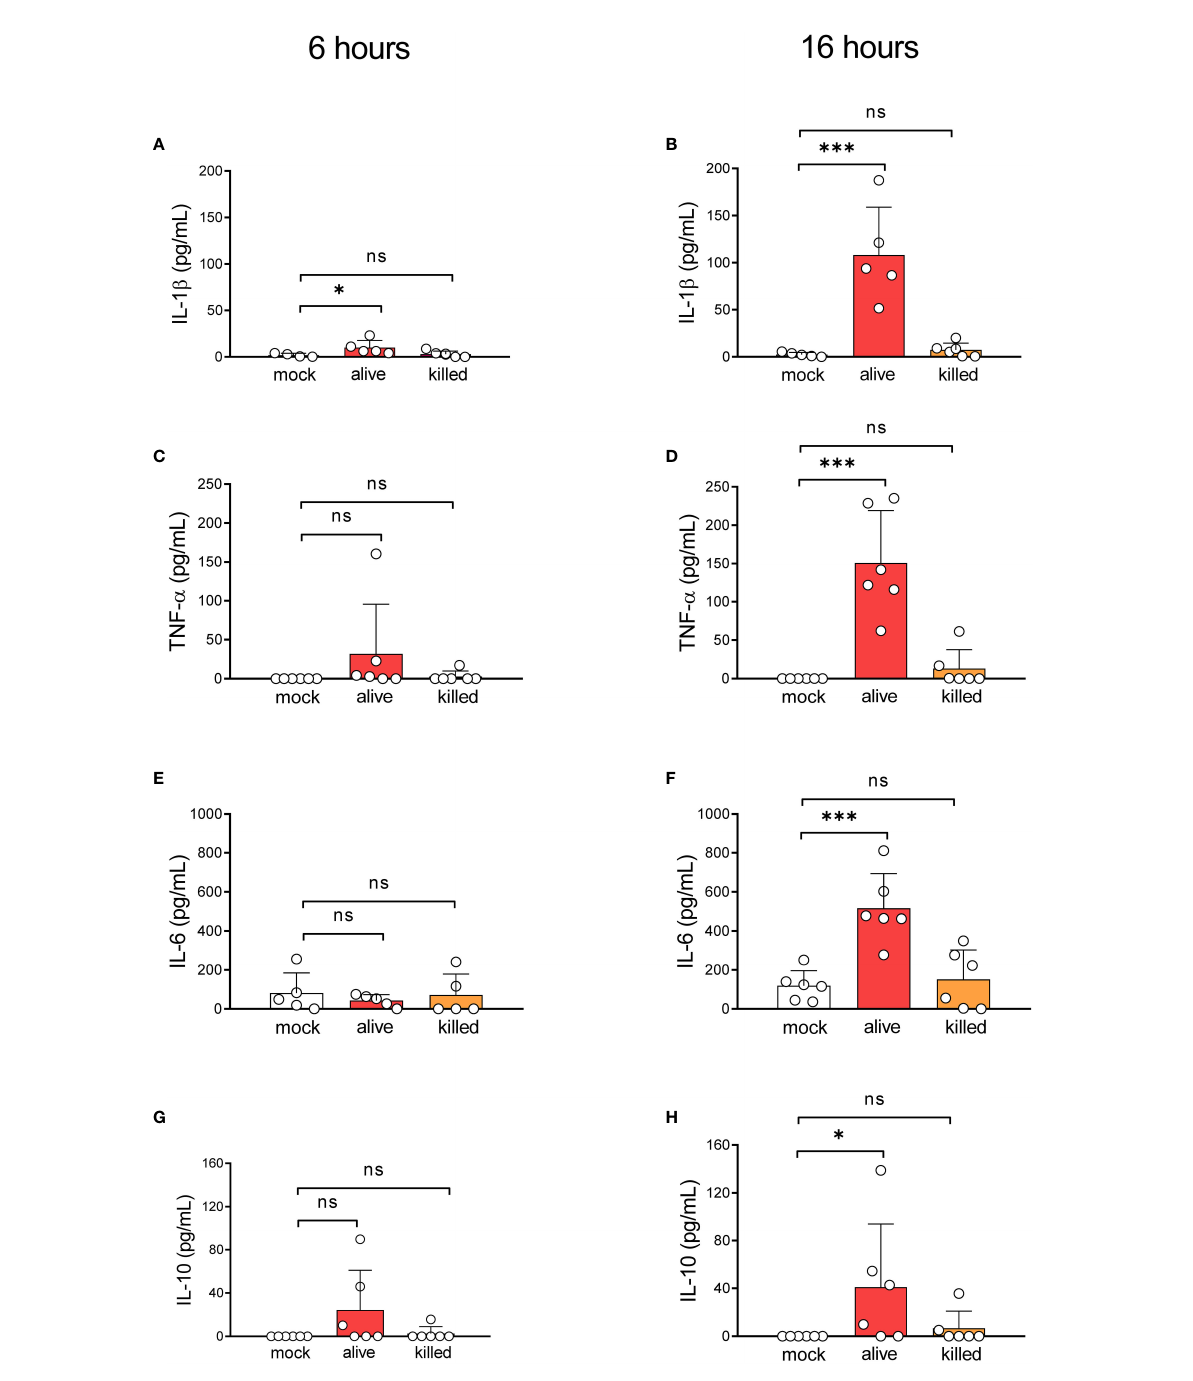
FIGURE 2 Alive resting spores of L corymbifera trigger early in fl ammatory responses by human monocytes. Pro-in fl ammatory cytokine release after six (A, C, E) and sixteen (B, D, F) hours of infection with L. corymbifera . (G, H) Anti-in fl ammatory cytokine production after infection with L. corymbifera . Bars represent means ± SD of data obtained from three independent experiments, each with one or two different donors, which are represented by dots. Differences among groups were assessed by one-way ANOVA for normally distributed data and Krustal-Wallis for non- normally distributed. * p < 0,05; *** p <0,001. S. proteins indicate surface proteins. ns indicates not signi fi